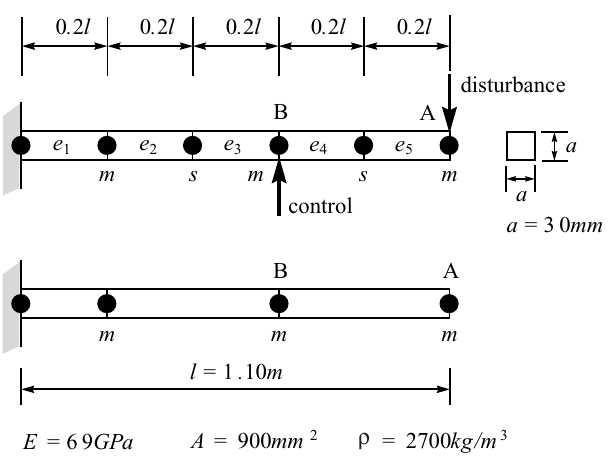
Fig. 4. Structure with 15 degrees reduced to 9 master degrees of freedom.